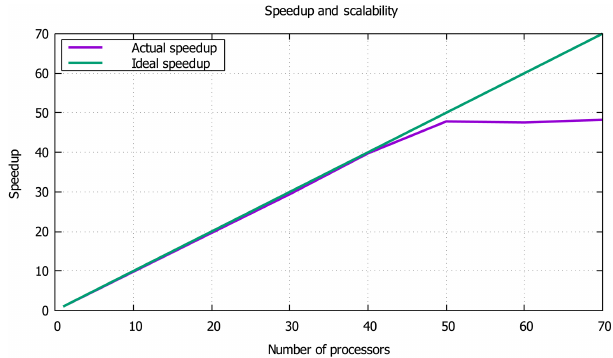
Figure 16. Parallel speedup with different numbers of processors. The green line is the ideal speedup, and the purple line is the actual